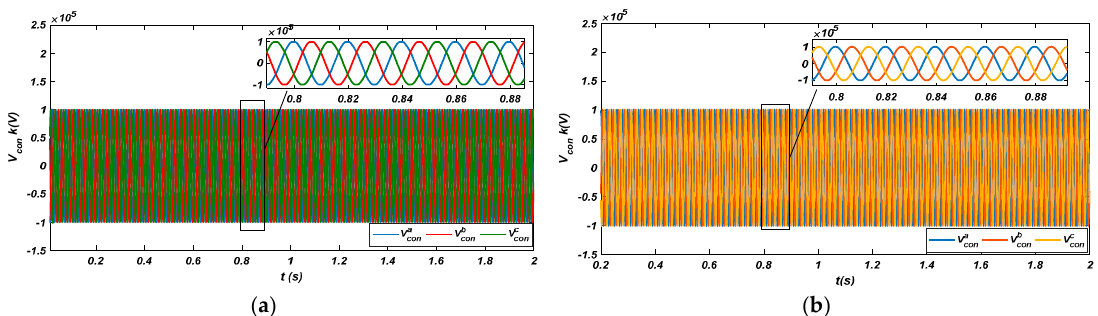
Figure 17. ( a ) Converter phase voltages using the API controller; ( b ) converter phase volatges using the PR controller.